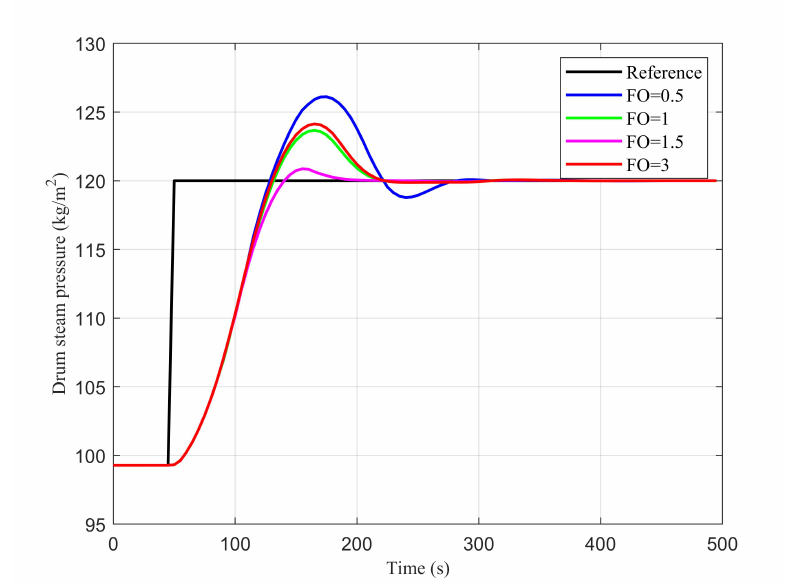
Figure 3. The drum steam pressure with different fractional orders.